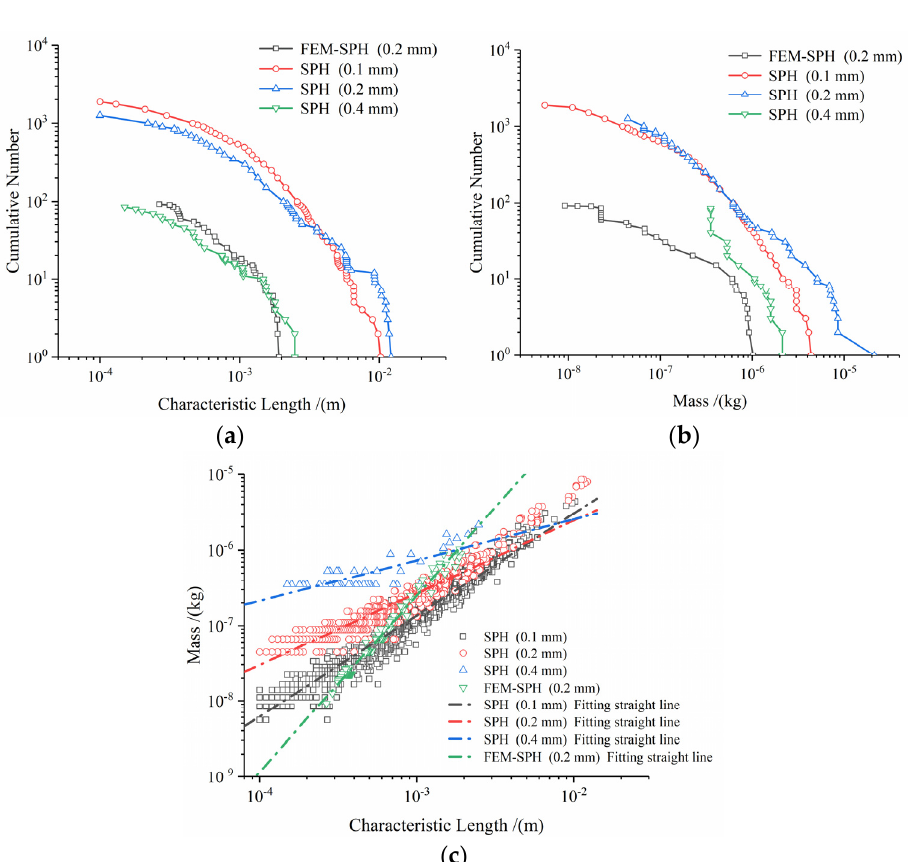
Figure 15. Comparison of fragment characteristic parameters between finite element method-smooth particle hydrodynamics and smooth particle hydrodynamics method. ( a ) Fragment characteristic length distribution; ( b ) fragment mass distribution; ( c ) fragment characteristic length vs. fragment mass.